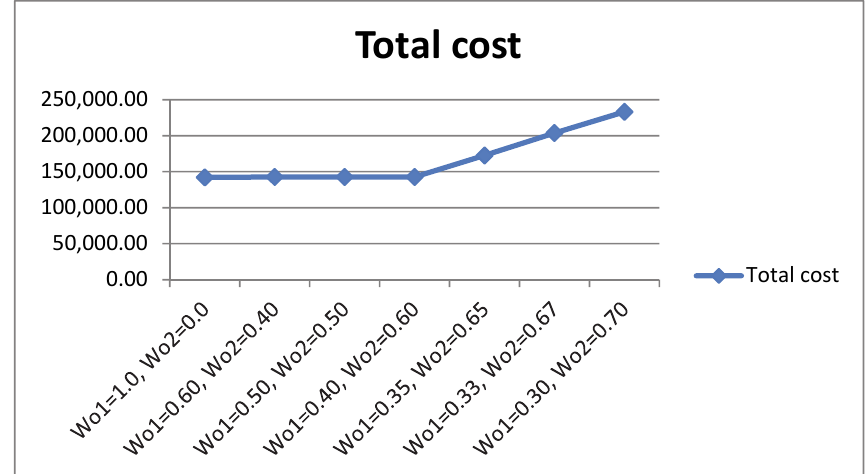
Fig. 12. Sensitivity analysis of total cost for different levels of w o1 , w o2